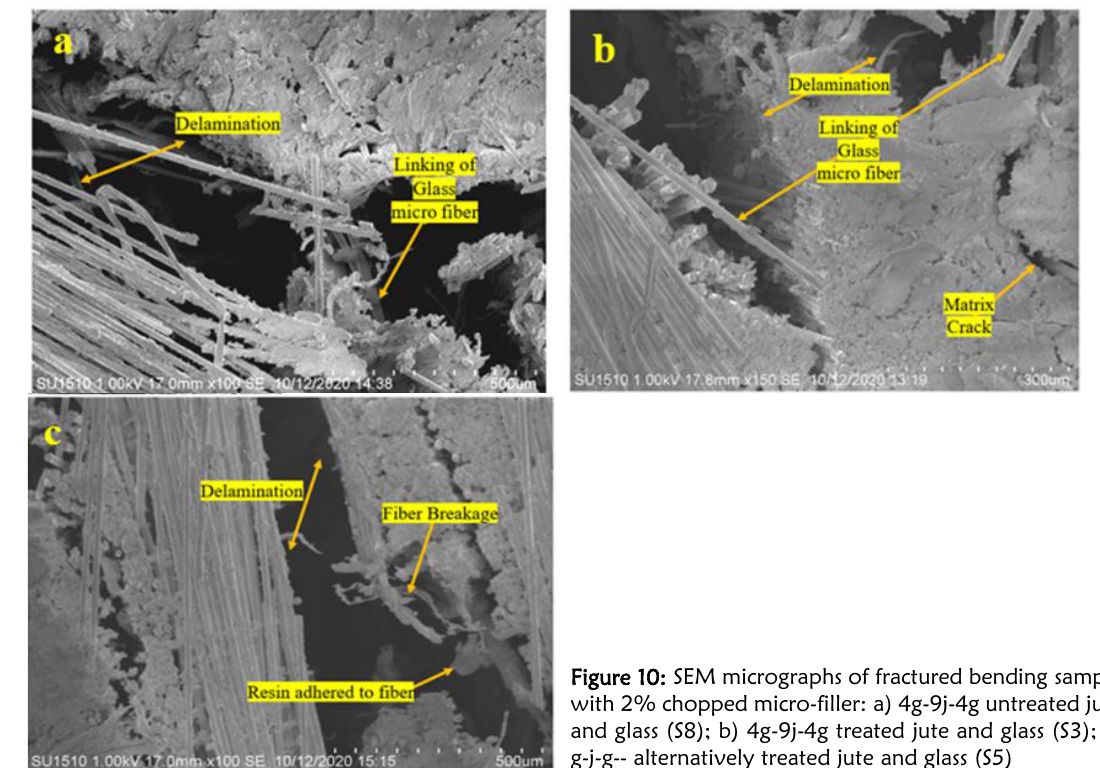
Figure 10: SEM micrographs of fractured bending sample with 2% chopped micro-filler: a) 4g-9j-4g untreated jute and glass (S8); b) 4g-9j-4g treated jute and glass (S3); c) g-j-g-- alternatively treated jute and glass